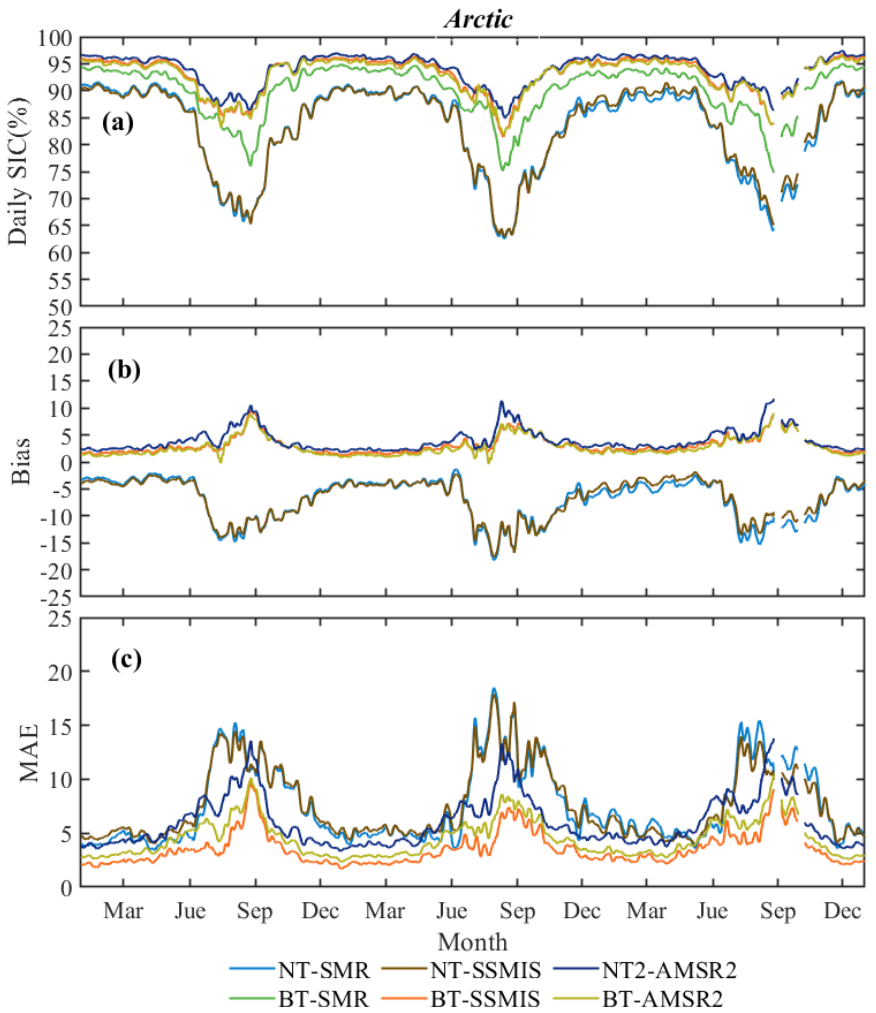
Figure 7. Arctic daily average SIC ( a ), bias ( b ) and MAE ( c ) from January 2019 to December 2021 for 25 km spatial resolution SIC datasets. Bias refers to the above SIC datasets minus BT − SMR daily average difference. MAE refers to mean absolute error.